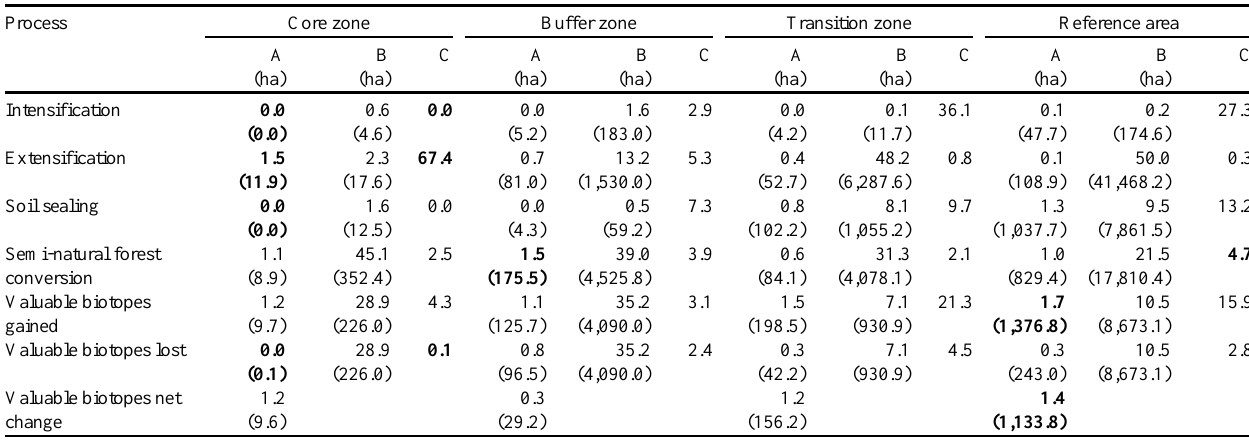
Table 6 . Comparison of key processes in the three management zones and outside the reserve (A = % of total area covered, B = % of total area covered by original classes in 1992, C = % of original classes converted by process, bold = best